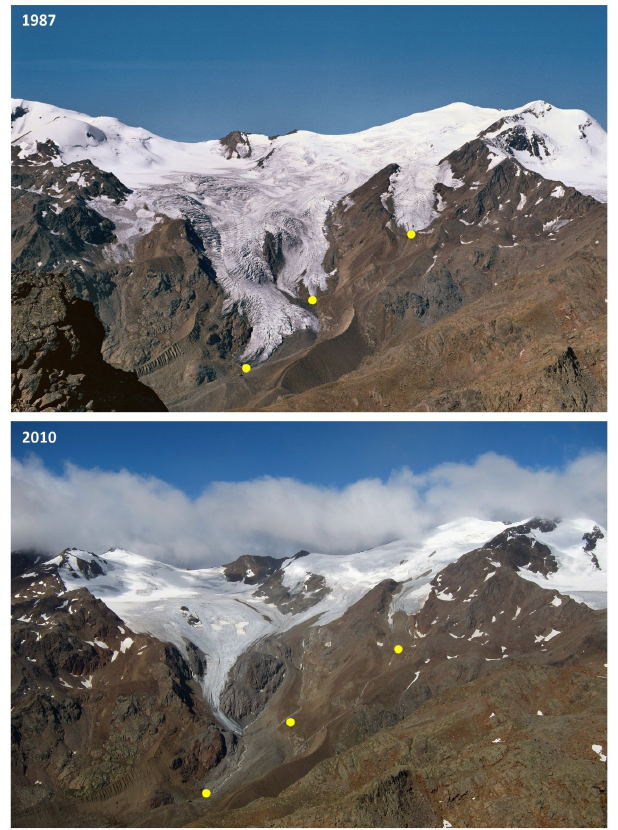
Fig. 3. Example of the current shrinking of glaciers in the Ortles-Cevedale group. Repeat photography of La Mare Glacier in late summer 1987 (photo Giuliano Bernardi, www.fotobernardi.it) and on 28 August 2010 (photo L. Carturan). The yellow circles indicate corresponding points in both photos.